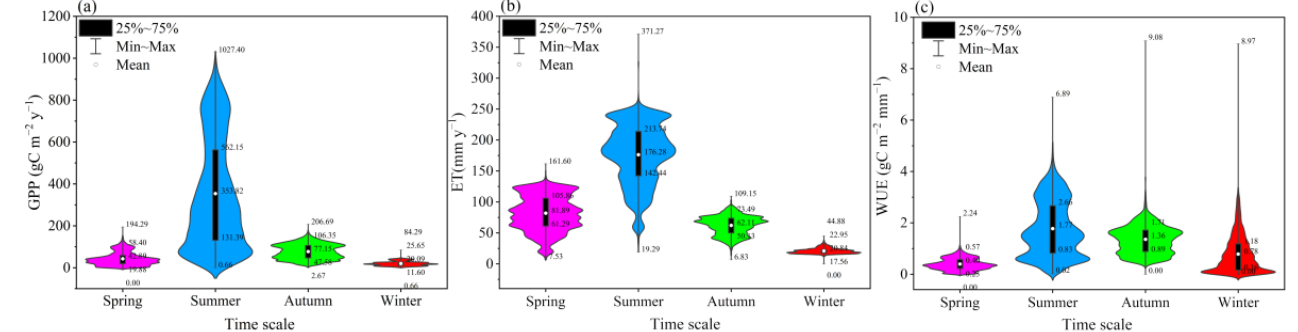
Figure 4. Mean values of ( a ) GPP, ( b ) ET, and ( c ) WUE in various seasons in Inner Mongolia.